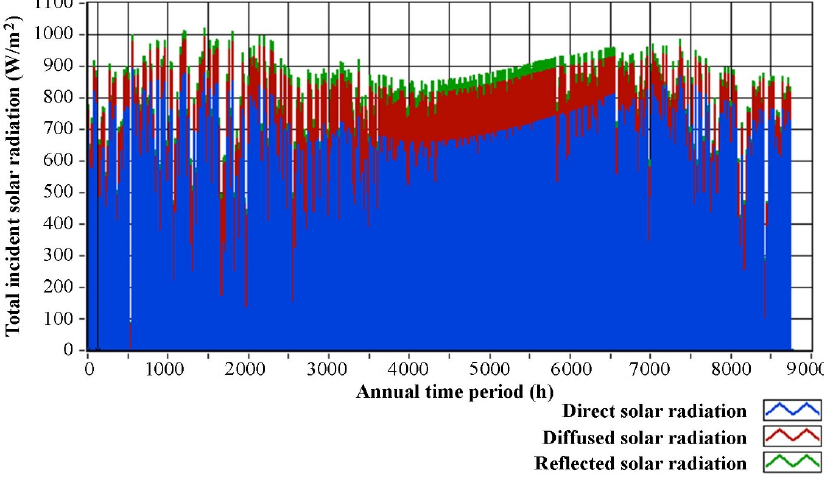
Figure 13. Annual variation of the total incident solar radiation for the installation angle of 45 ◦ and for for south orientation. south orientation.